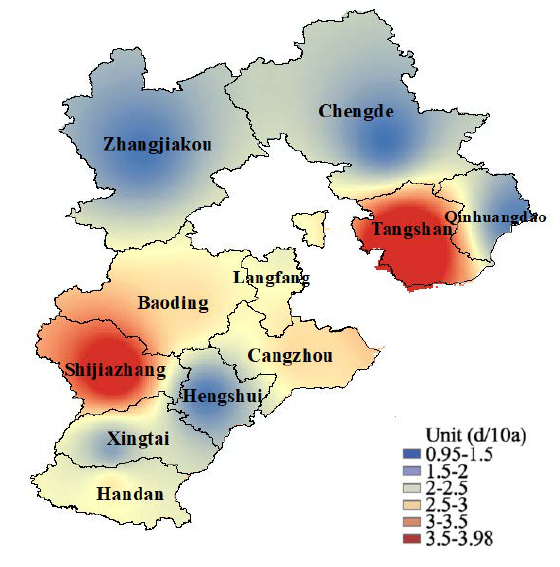
Fig. 3 Risk assessment of heavy rain disaster in Hebei Province from 08:00 on July 18 to 08:00 on July 21, 2017